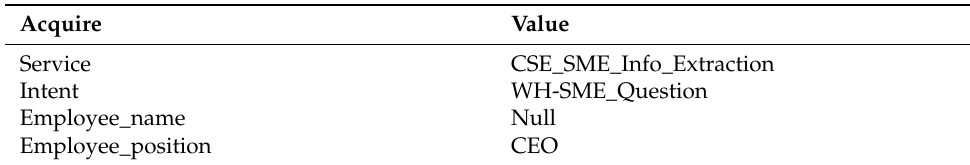
Table 2. Sample representation of frame